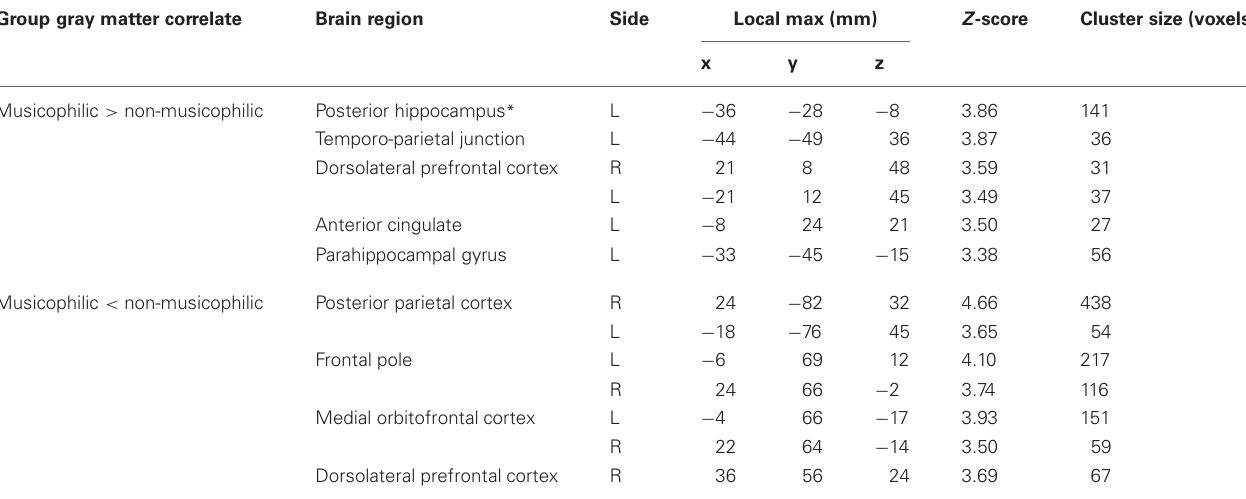
Table 2 | Summary of voxel-based morphometry findings. Group gray matter